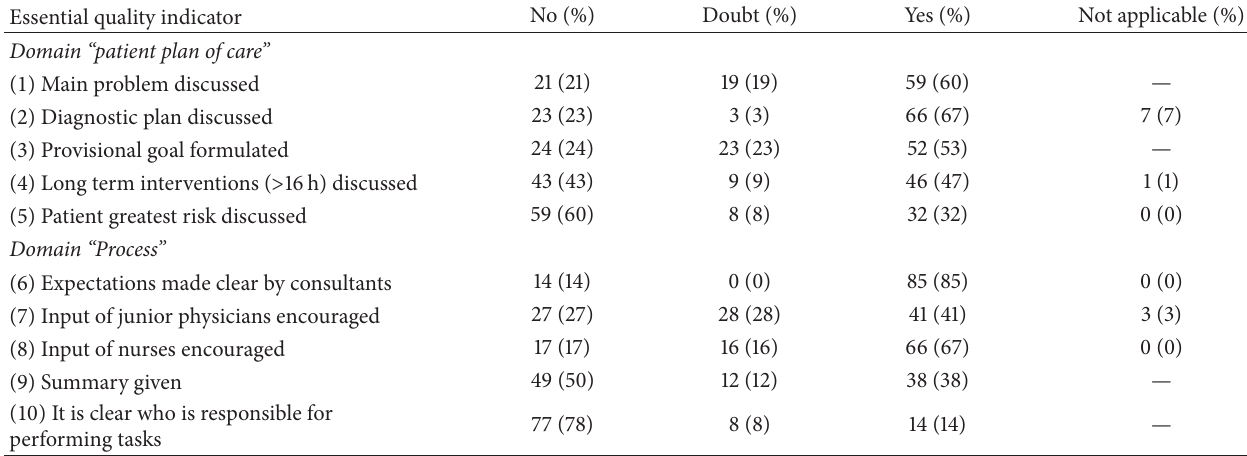
Table 2: Implementation of the checklist of 10 essential indicators in clinical scenarios in the intensive care unit ∗ . Essential quality indicator